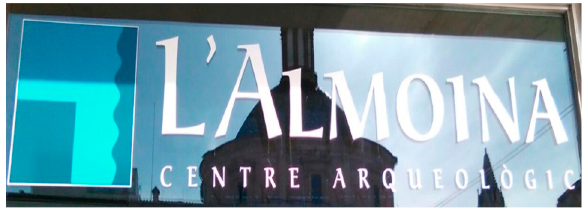
Figure 18. Valencia: Valencian-only sign on an archeological centre.